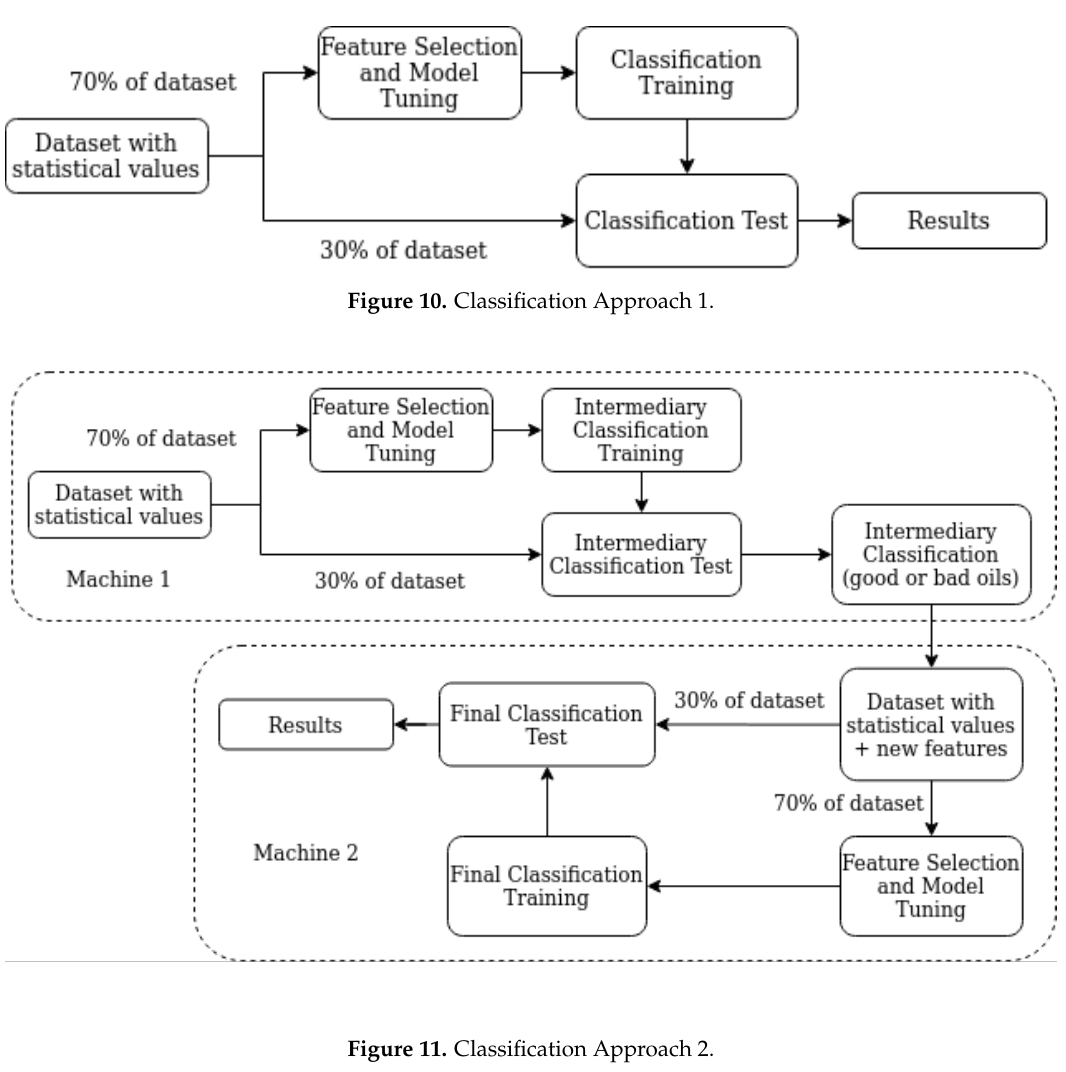
Figure 11. Classification Approach